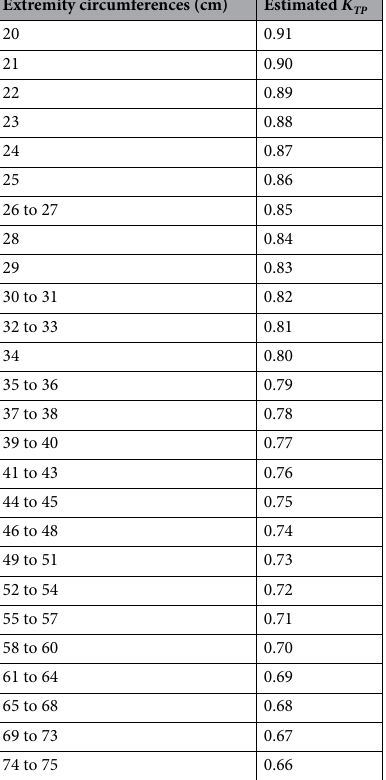
Table 3. Tissue padding coefficient (K TP ) adjusted to limb circumferences 17